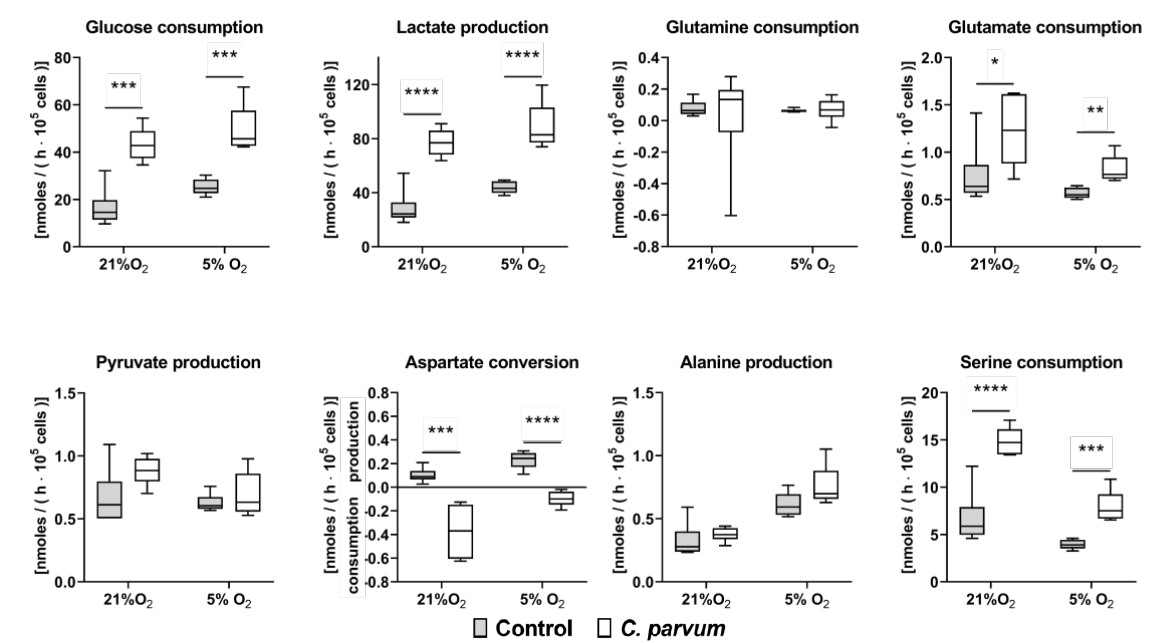
Figure 4. Glucose, lactate, pyruvate, aspartate, glutamine, glutamate, alanine and serine conversion rates in uninfected and C. parvum -infected HCT-8 cultivated in glutamine-starved medium (0.02 mM) at hyperoxia (21% O 2 ) and physioxia (5% O 2 ) ( n = 6, each group). In comparison to glutamine-supplemented cultivation conditions the parasite infection rate slightly dropped in glutamine starved medium (21% O 2 : 40 ± 3%; 5% O 2 : 28 ± 7%). Conversion rates were analysed at 48 h p. i. in the cell culture supernatants of the cells. Metabolic conversion rates are plotted as interleaved box and whiskers plots showing minimum to maximum values with line at the medians. Statistical significance (* = p ≤ 0.05, ** = p ≤ 0.01, *** = p ≤ 0.001, **** = p ≤ 0.0001) was determined by t -test for independent samples.